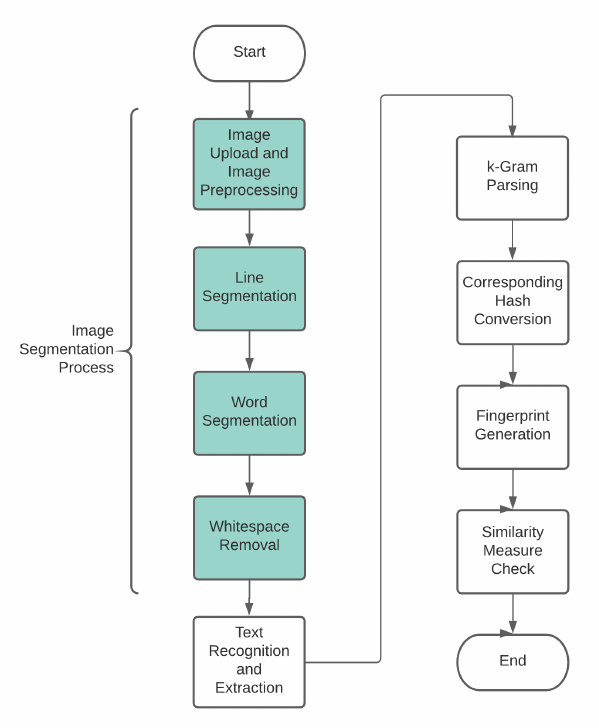
Figure 6. Proposed Similarity Check-Process